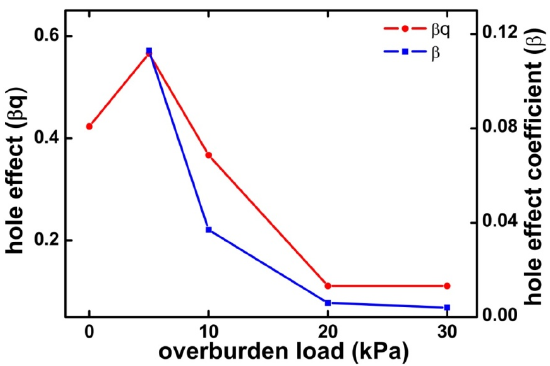
Figure 12. Plot of the damaged hole effect and effect coefficient versus overburden load.